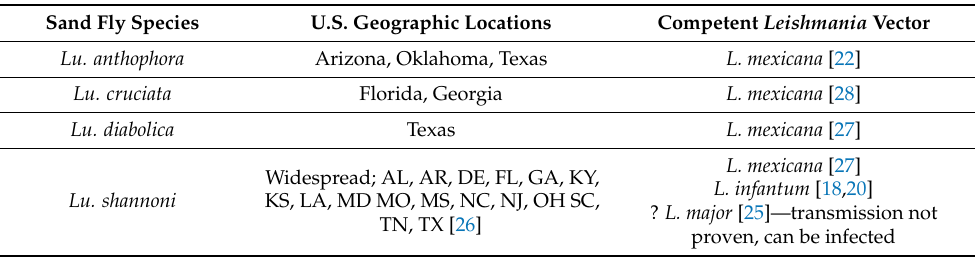
Table 1. U.S. Sand Flies that may Transmit Leishmaniasis. Sand Fly